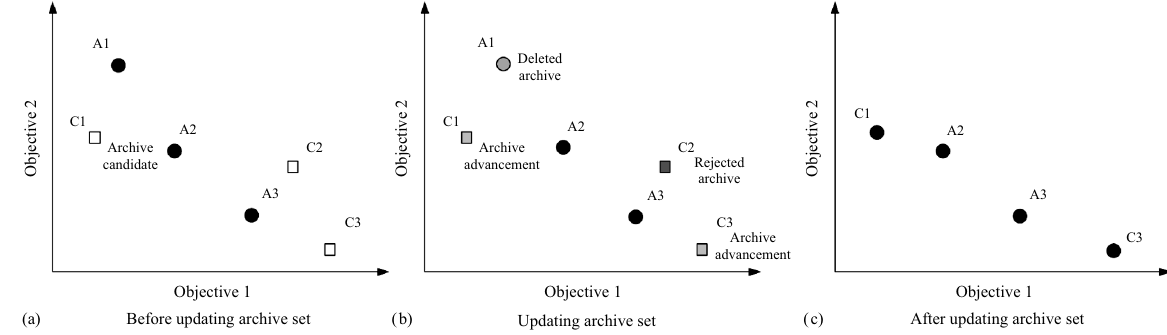
Fig. 4. Illustration of archiving scheme